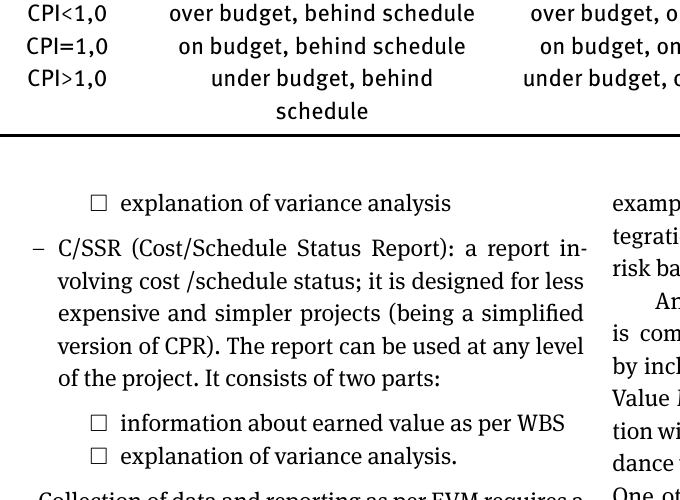
Table 1: The dependencies between SPI and CPI values, based on: [1, 3] SPI and CPI SPI < 1,0 SPI=1,0 SPI > 1,0 CPI < 1,0 over budget, behind schedule over budget, on schedule over budget, ahead of schedule CPI=1,0 on budget, behind schedule on budget, on schedule on budget, ahead of schedule CPI > 1,0 under budget, behind under budget, on schedule under budget, ahead of schedule